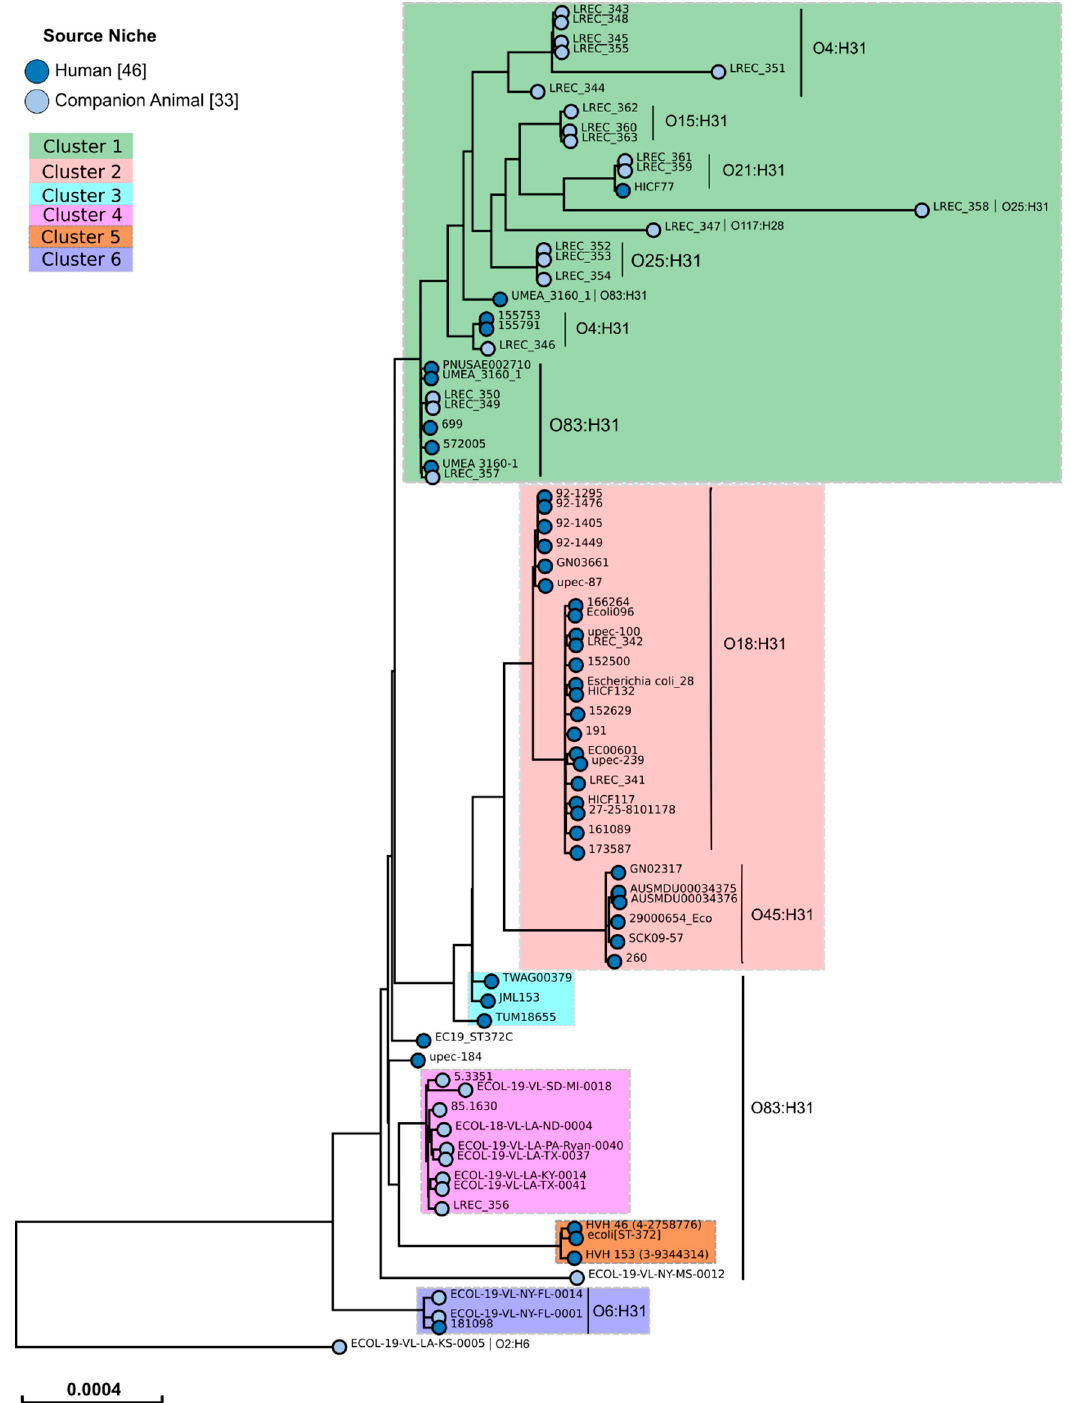
Figure 1. SNP-tree of 79 representative ST372 E. coli genomes from 46 human strains and 33 canine strains. Tree visualization by EnteroBase [61]. The 33 genomes from canine strains are representatives of the different clusters identified in the SNP matrix of a previous SNP-tree performed with the 197 genomes analyzed in this study. The identified serotypes are listed beside the vertical line.